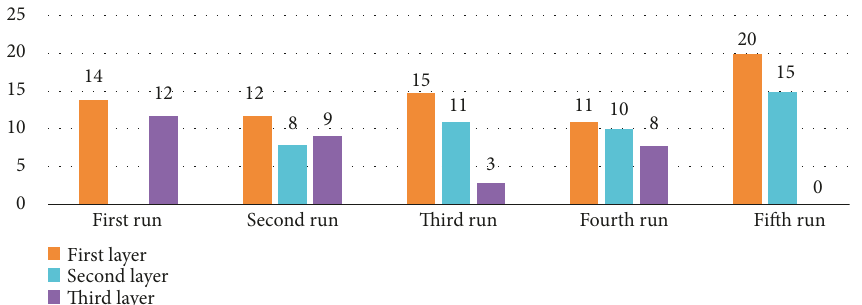
Figure 4: The best structures obtained by the grey wolf algorithm in five different implementations.